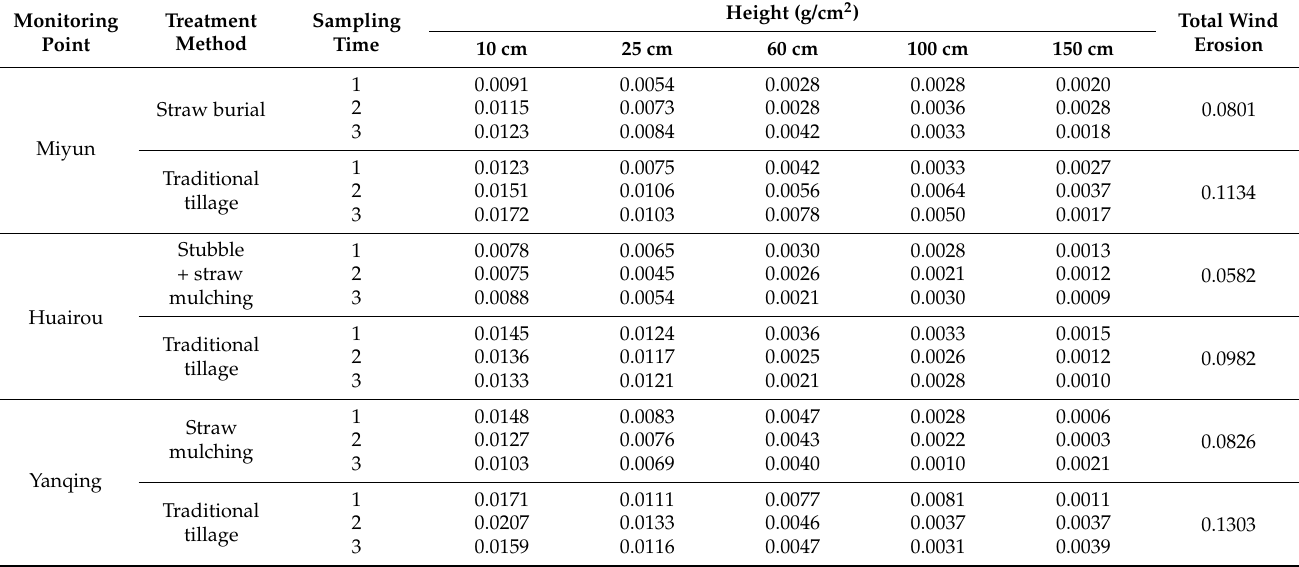
Table 1. Wind erosion at each height (g/cm 2